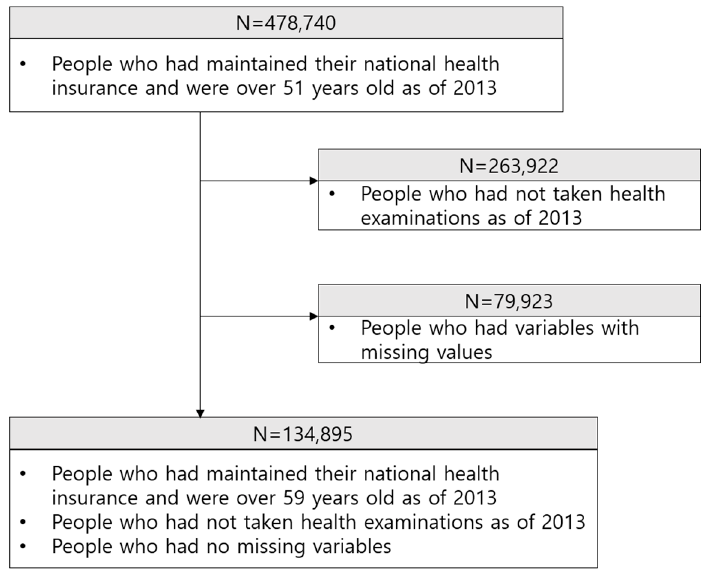
Figure 4. Data workflow.